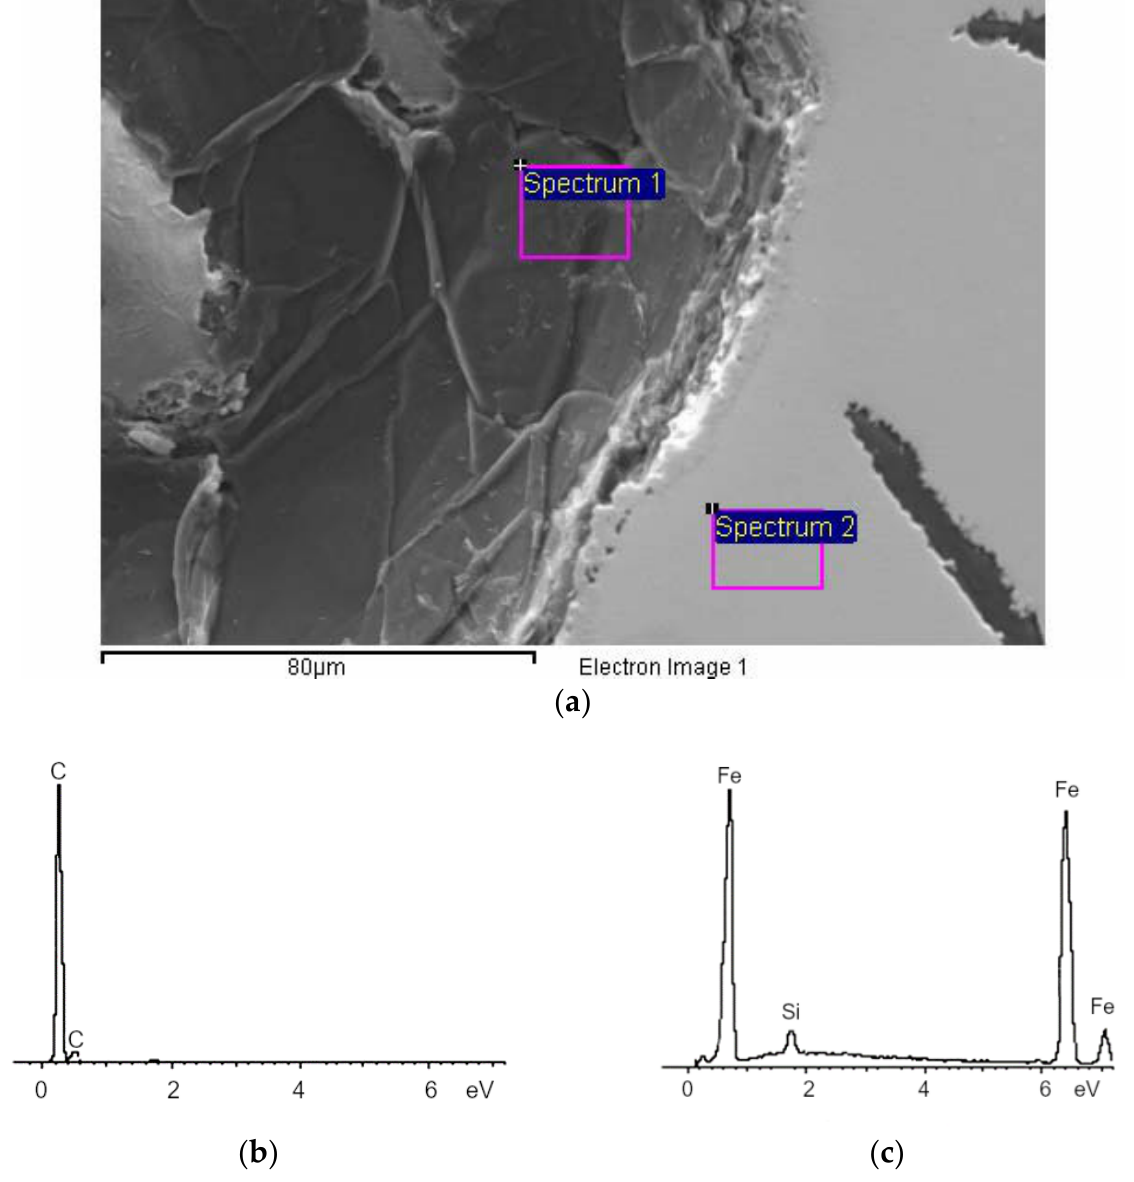
Figure 9. ( a ) Analysis of chemical composition of lathe bed casting on surface of internal porosity and metal matrix, ( b ) results of EDS analysis for inside of void, and ( c ) metal matrix.